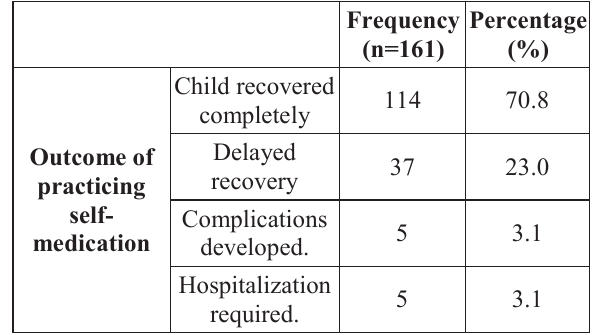
Table-5: Outcome of practicing